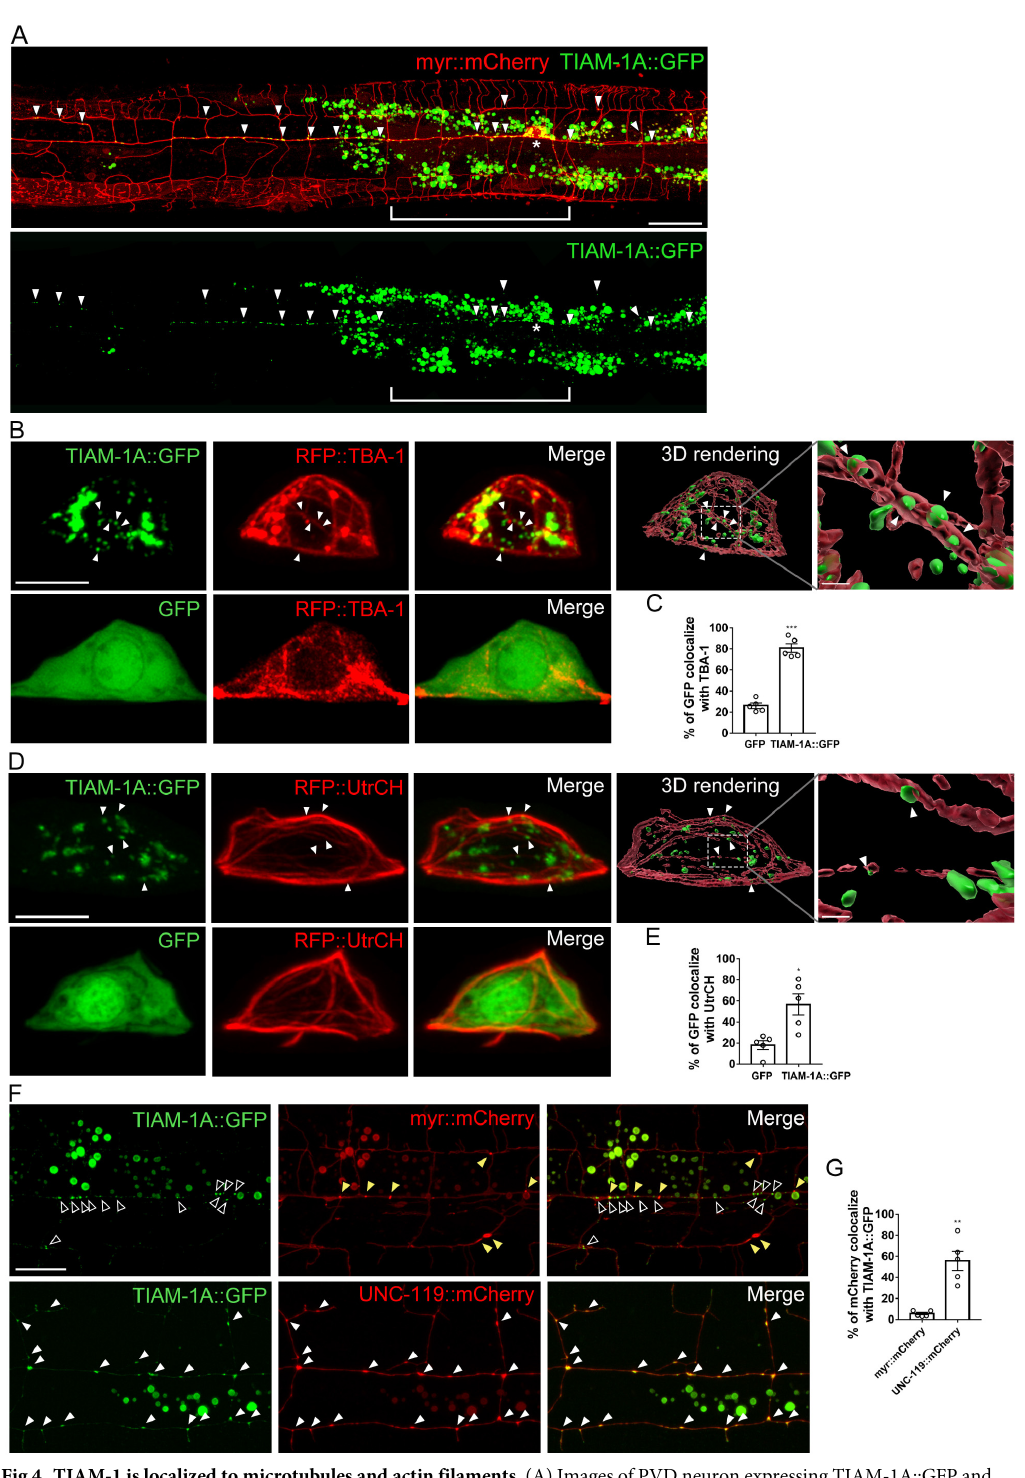
Fig 4. TIAM-1 is localized to microtubules and actin filaments. (A) Images of PVD neuron expressing TIAM-1A::GFP and myr::mCherry (ntuEx278) . TIAM-1A::GFP is specifically localized in dendrites (arrowheads), but not present in the axon (brackets). Scale bar, 20 μ m. (B and D) PVD neuron cell body expressing the MT marker RFP::TBA-1 (B) or the F-actin marker RFP::UtrCH (D) in worms with TIAM-1A::GFP (top) or GFP control (bottom). Arrowheads indicate TIAM-1A::GFP signal. The 3D surface reconstructions are generated by Imaris software (top right). Scale bar, 5 μ m or 0.3 μ m (magnified images).